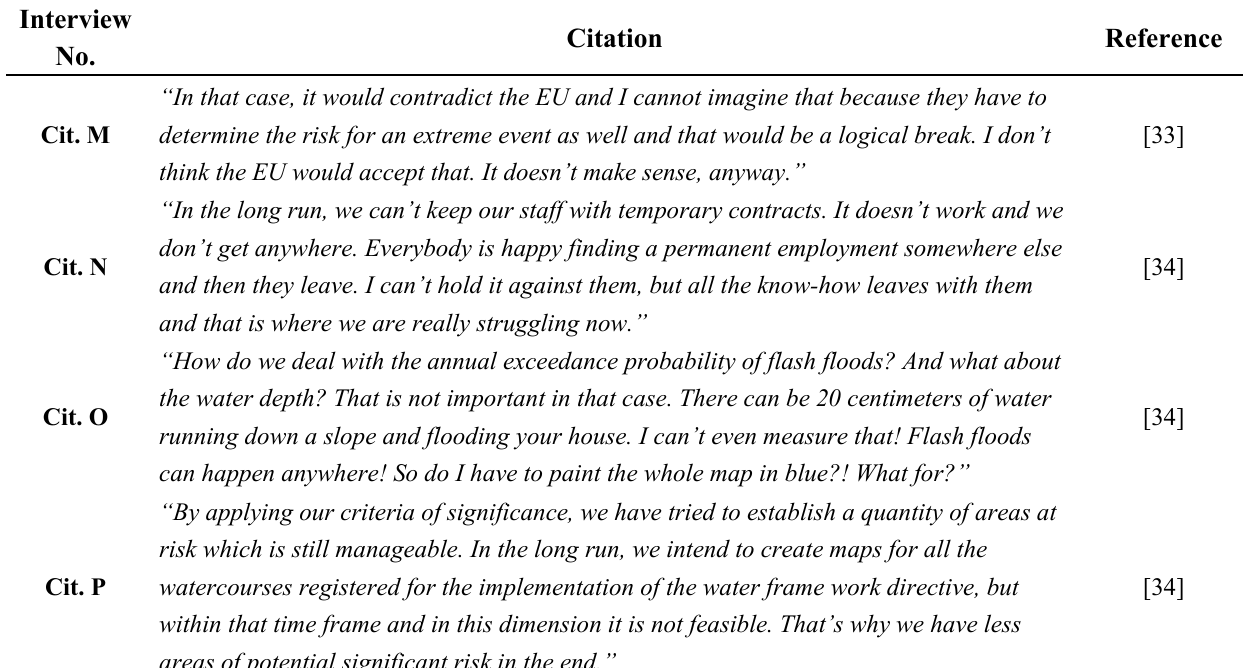
Table 5. Other comments on the chances to effectively implement the floods